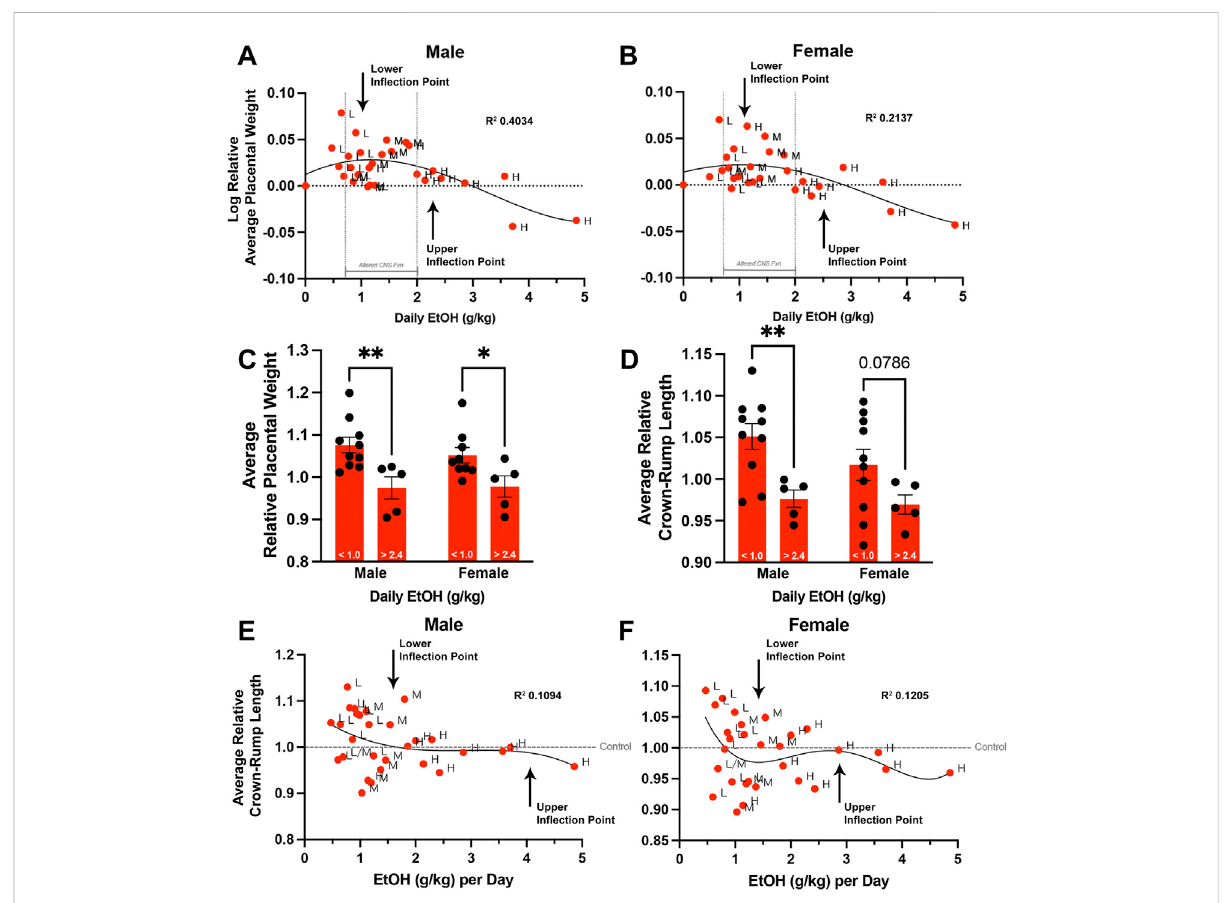
FIGURE 5 Chronic preconception paternal ethanol exposures induce biphasic, dose-dependent effects on offspring fetoplacental growth. We used nonlinear regression to compare the sire ’ s daily ethanol dose to the log-transformed, average relative placental weights of (A) male and (B) female offspring. ( n = 29 averages across each absolute daily dose). Comparison of male and female (C) average relative placental weight and (D) average relative crown-rump lengths between offspring sired by males below ( < 1.0 g/kg) and above ( > 2.4 g/kg) the identi fi ed in fl ection points (two- way ANOVA with n = 10 lower-dose and 5 upper-dose). Nonlinear regression comparing sire daily ethanol dose to (E) male and (F) female average relative crown-rump lengths ( n = 29 averages across each absolute daily dose). We used a fourth-order polynomial model with least squares regression to identify in fl ection points. We eliminated outliers at Q = 1% and veri fi ed model fi t using R squared analyses combined with Runs testing. Error bars represent the standard error of the mean, * p < 0.05, ** p <